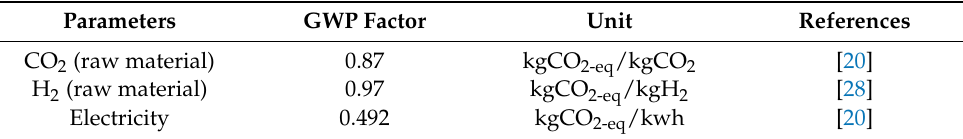
Table 5. GWP factor for environmental